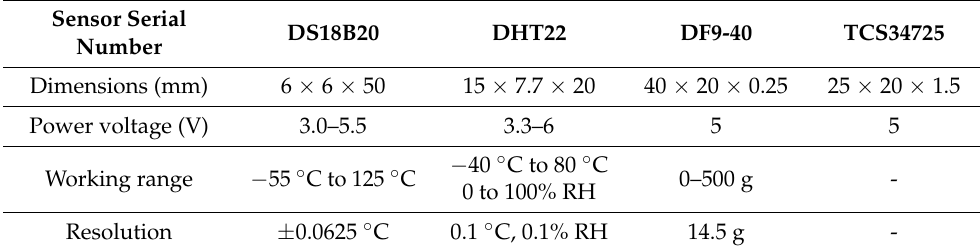
Table 1. Technical specifications of the sensors.